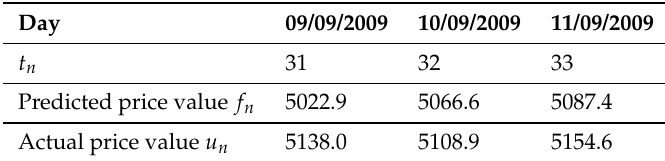
Table 2. Table comparing the actual and predicted prices for three days of the FTSE100 using Equation